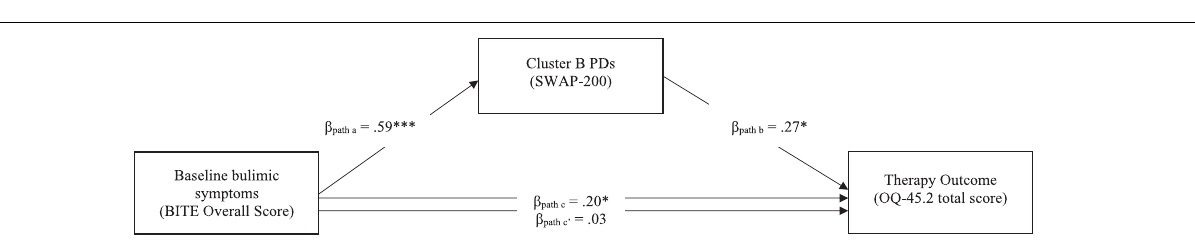
FIGURE 2 | Mediation Model with Cluster B of the SWAP-200 PD Scales as a Mediator of the Effect of Overall Bulimic Symptoms at Intake on Therapy Outcome ( N = 107). SWAP-200 = Shedler-Westen Assessment Procedure-200 (Westen and Shedler, 1999a,b); BITE = Bulimic Investigatory Test, Edinburgh (BITE; Orlandi et al., 2005); OQ-45.2 = Outcome Questionnaire-45.2 total score (Lambert et al., 2010). Confidence intervals computed using bootstrap